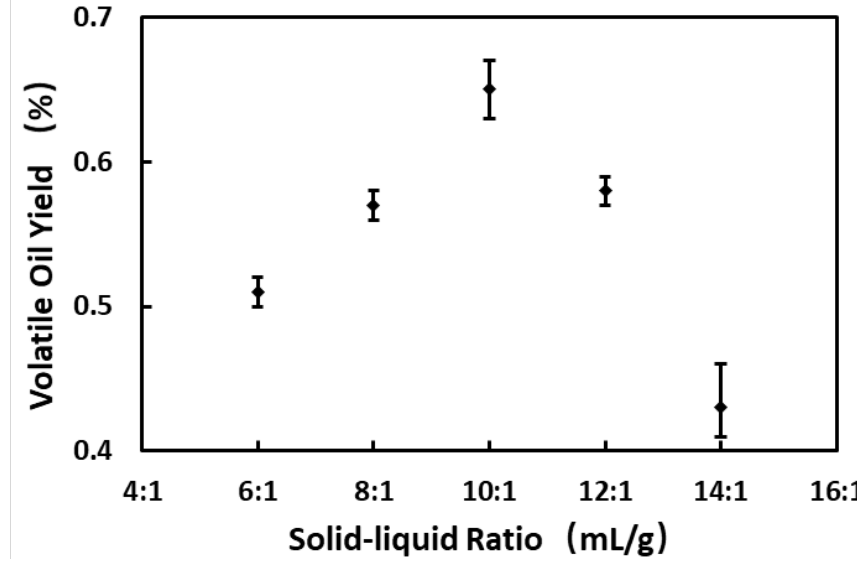
Figure 5. The effect of solid – liquid ratio on the volatile oil yield ( n = 3).